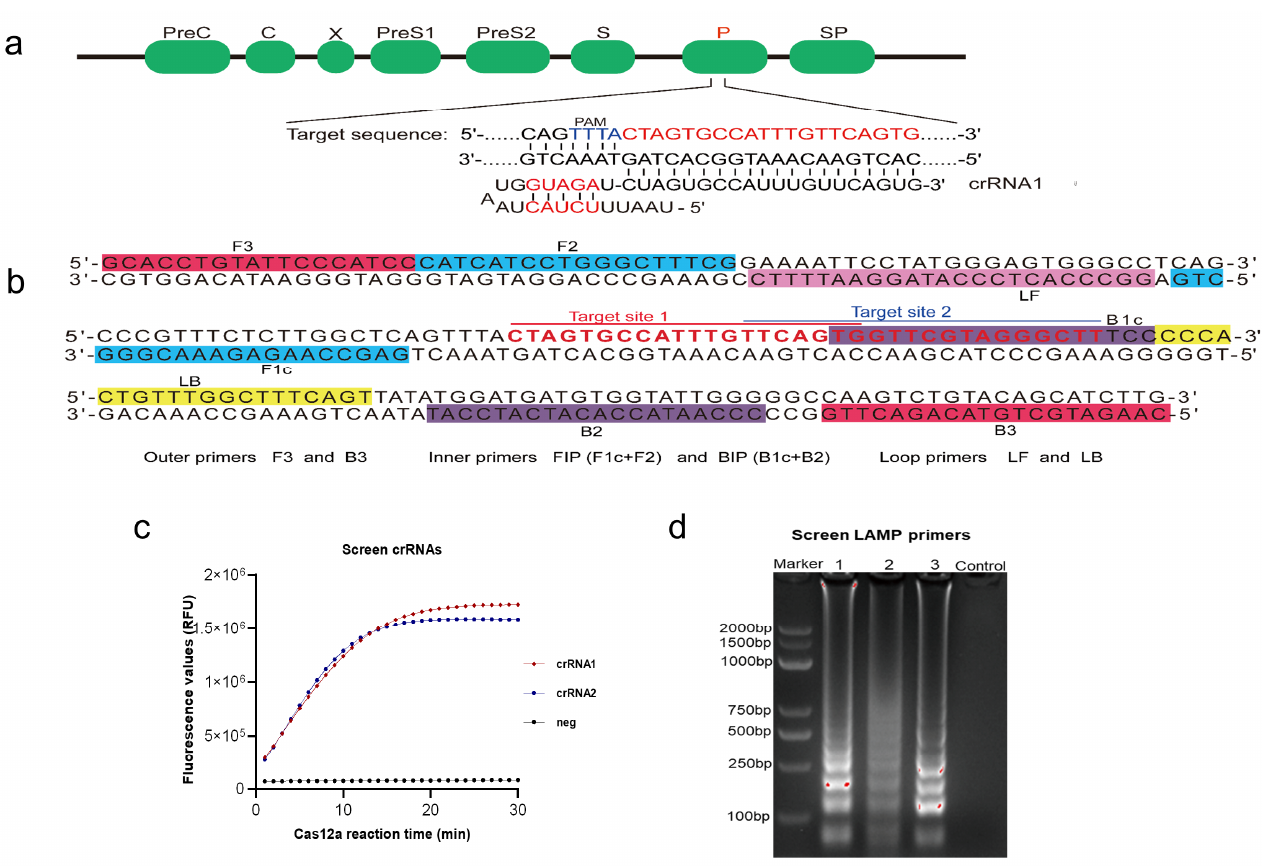
Figure 2. Preparation of Cas12a-DETECTR system. ( a ) HBV genome map shows target and crRNA sequences on the polymerase coding region. ( b ) The sequence and location of LAMP primers and target sites in the HBV genome. ( c ) To screen good crRNA, we performed Cas12a assays on 10 7 copies/ µ L of HBV plasmids by using crRNA 1 and 2; neg: parallel control without crRNA addition for the same Cas12a assay. ( d ) To screen the best LAMP primer, after the amplification of different LAMP primers, we performed agarose gel